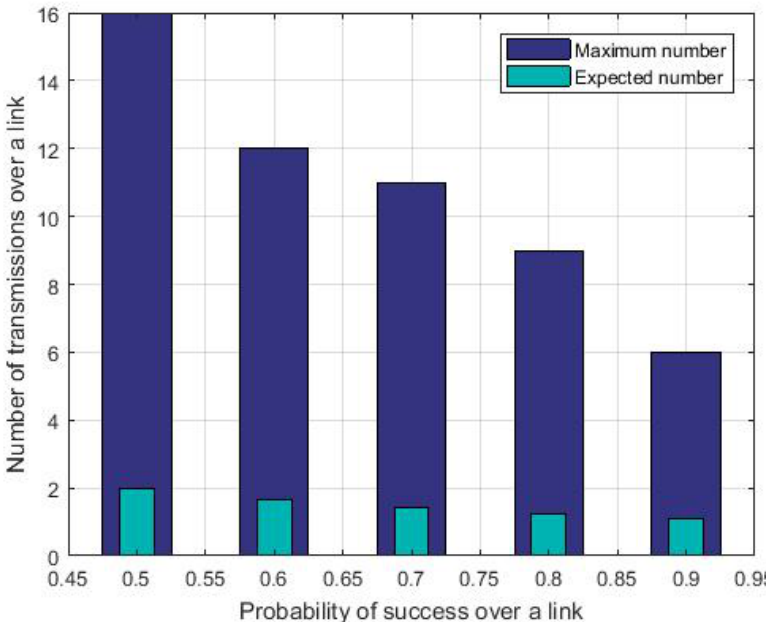
Figure 2. Expected number of transmissions versus MFair Maximum number of transmissions over a